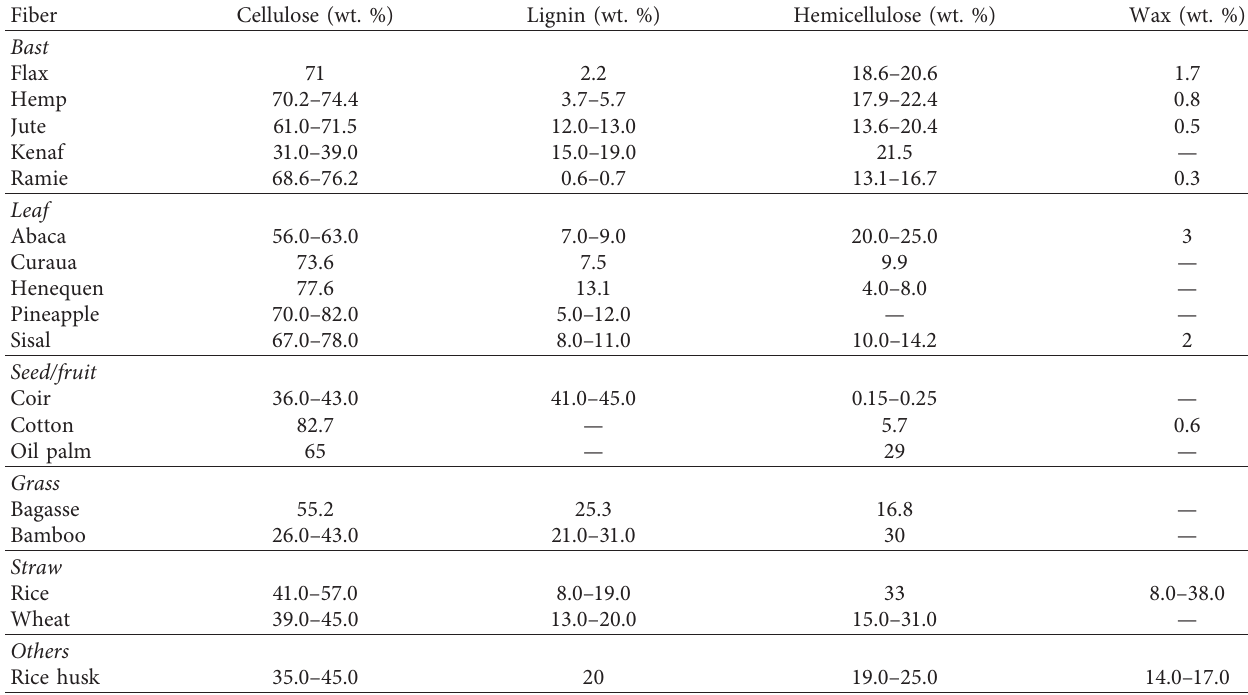
Table 2: Chemical composition of some common natural fibers